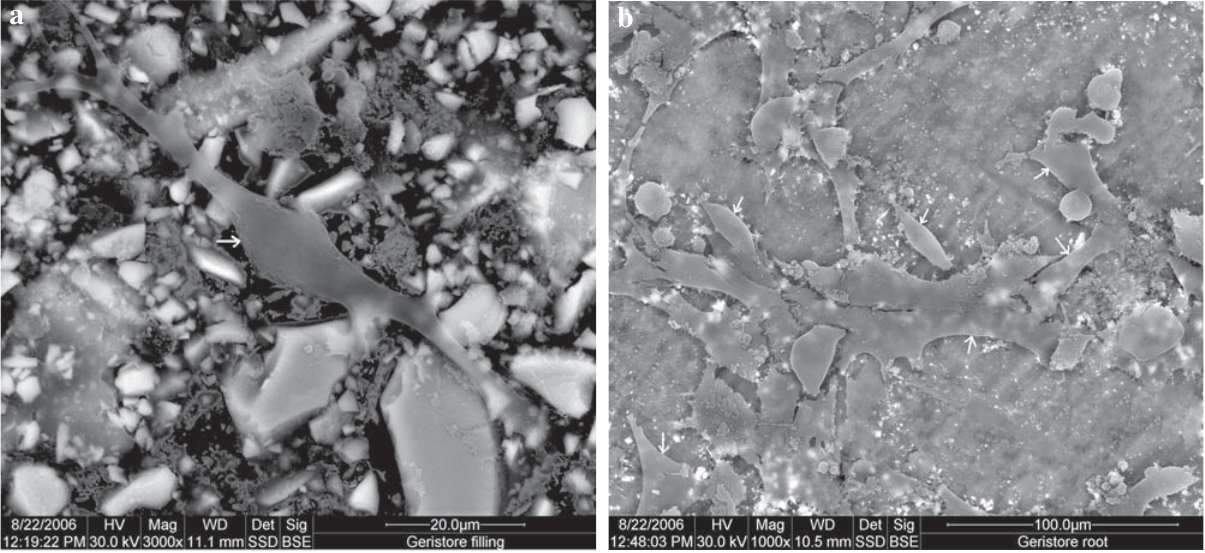
Figure 4 (cid:7)(cid:12) (cid:31)(cid:21)(cid:15)(cid:6)(cid:6)(cid:5)(cid:6)(cid:13)(cid:12) (cid:3)(cid:14)(cid:3)(cid:21)(cid:17)(cid:16)(cid:9)(cid:6)(cid:12) (cid:8)(cid:5)(cid:21)(cid:16)(cid:9)(cid:4)(cid:21)(cid:9)(cid:22)(cid:3)(cid:12) (cid:24)(cid:31)!"(cid:29)(cid:12) (cid:8)(cid:5)(cid:21)(cid:16)(cid:9)(cid:13)(cid:16)(cid:15)(cid:22)(cid:18)(cid:12) (cid:9)(cid:23)(cid:12) <(cid:3)(cid:16)(cid:5)(cid:4)(cid:17)(cid:9)(cid:16)(cid:3)%(cid:12) (cid:24)(cid:15)(cid:29)(cid:12) (cid:8)(cid:15)(cid:17)(cid:3)(cid:16)(cid:5)(cid:15)(cid:14)(cid:12) (cid:4)(cid:19)(cid:16)(cid:23)(cid:15)(cid:21)(cid:3)(cid:12) (cid:24)(cid:9)(cid:16)(cid:5)(cid:13)(cid:5)(cid:6)(cid:15)(cid:14)(cid:12) (cid:8)(cid:15)(cid:13)(cid:6)(cid:5)(cid:11)(cid:21)(cid:15)(cid:17)(cid:5)(cid:9)(cid:6)(cid:12) (cid:25)(cid:26)(cid:27)(cid:27)(cid:27)(cid:28)(cid:29)*(cid:12)(cid:24)/(cid:29)(cid:12)(cid:16)(cid:9)(cid:9)(cid:17)(cid:12)(cid:4)(cid:19)(cid:16)(cid:23)(cid:15)(cid:21)(cid:3)(cid:12)(cid:24)(cid:9)(cid:16)(cid:5)(cid:13)(cid:5)(cid:6)(cid:15)(cid:14)(cid:12)(cid:8)(cid:15)(cid:13)(cid:6)(cid:5)(cid:11)(cid:21)(cid:15)(cid:17)(cid:5)(cid:9)(cid:6)(cid:12)=(cid:26)(cid:27)(cid:27)(cid:27)(cid:28)(cid:29)(cid:30)(cid:12)$(cid:16)(cid:16)(cid:9);(cid:4)(cid:12)(cid:5)(cid:6)(cid:10)(cid:5)(cid:21)(cid:15)(cid:17)(cid:3)(cid:12)(cid:21)(cid:3)(cid:14)(cid:14)(cid:4)